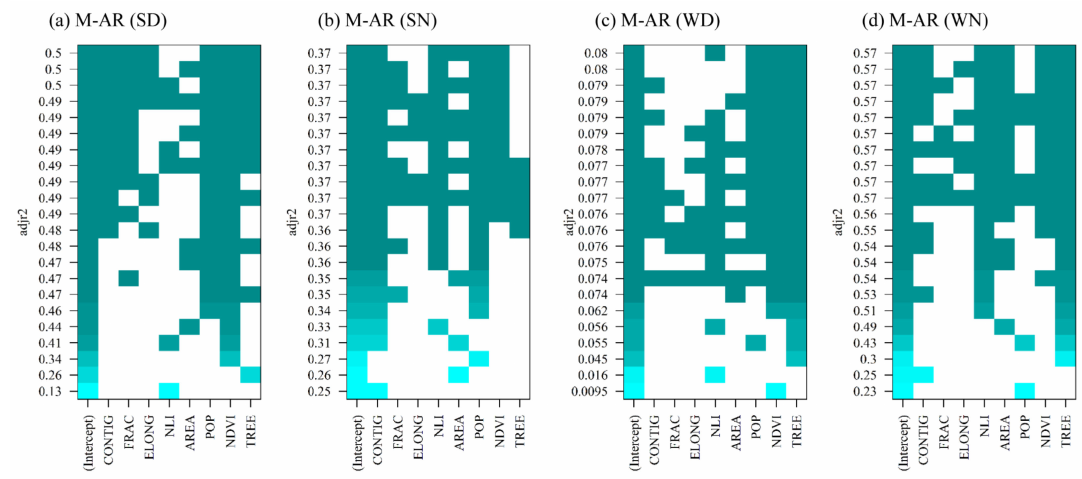
Figure A1. All-subsets regression results of summer daytime (SD) ( a ), summer nighttime (SN) ( b ), winter daytime (WD) ( c ), and winter nighttime (WN) ( d ). The horizontal axis represents the explanatory variables that passed the significance test, with “intercept” as the intercept term in regression model. The colorful dots indicate the variables which entered the